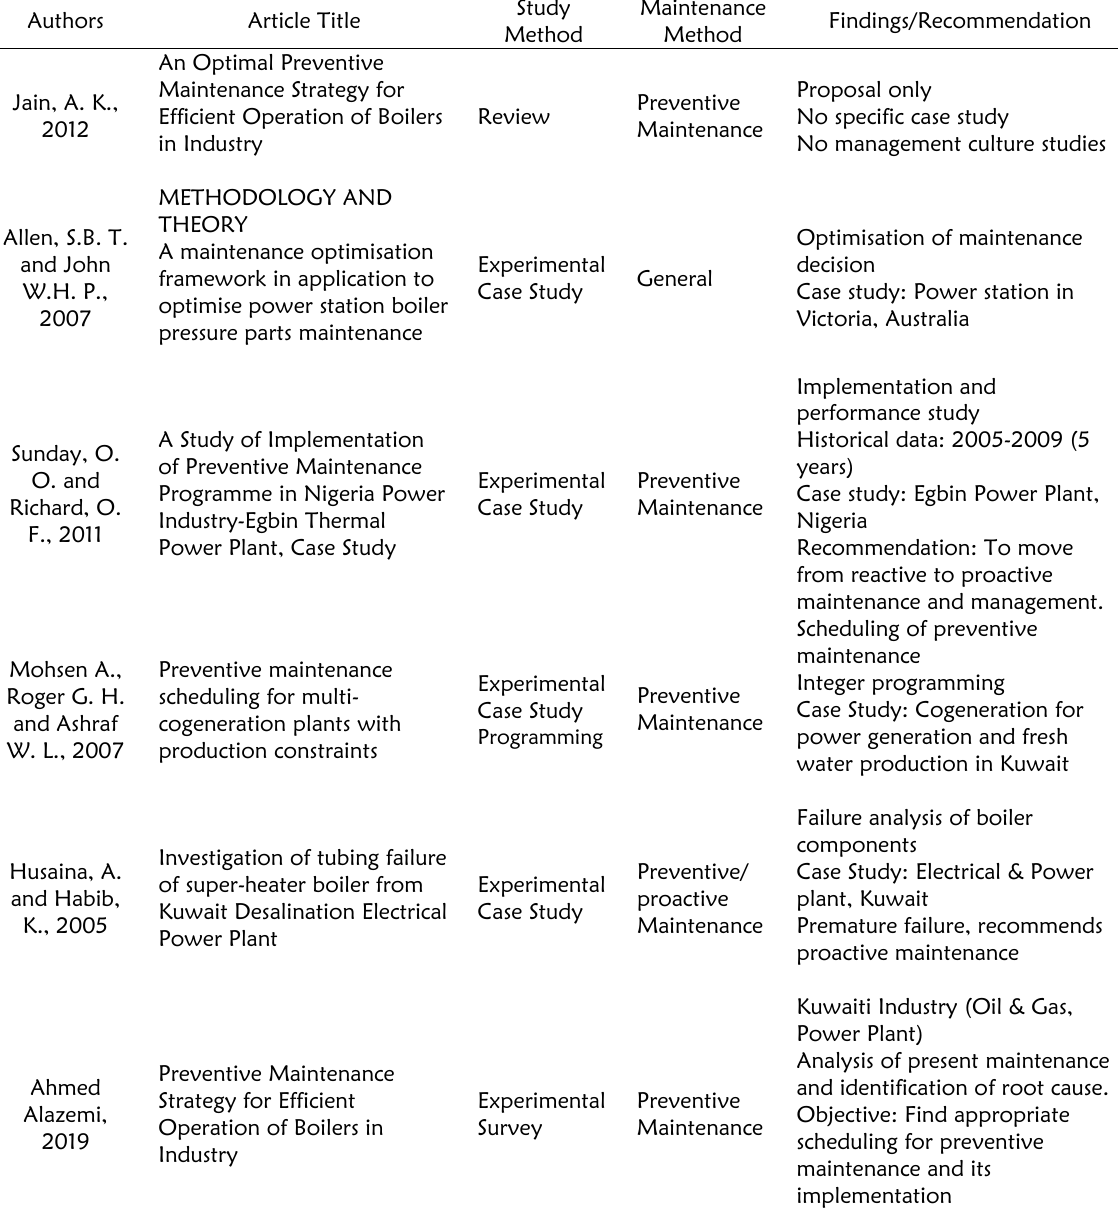
Table 0.1: Research gap analysis based on literature